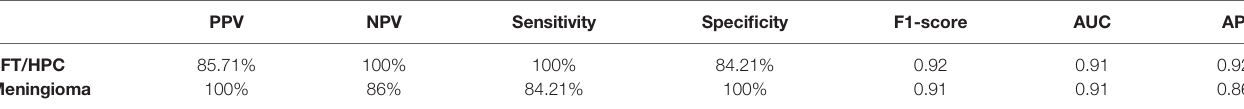
TABLE 3 | Quantitative results for the validation